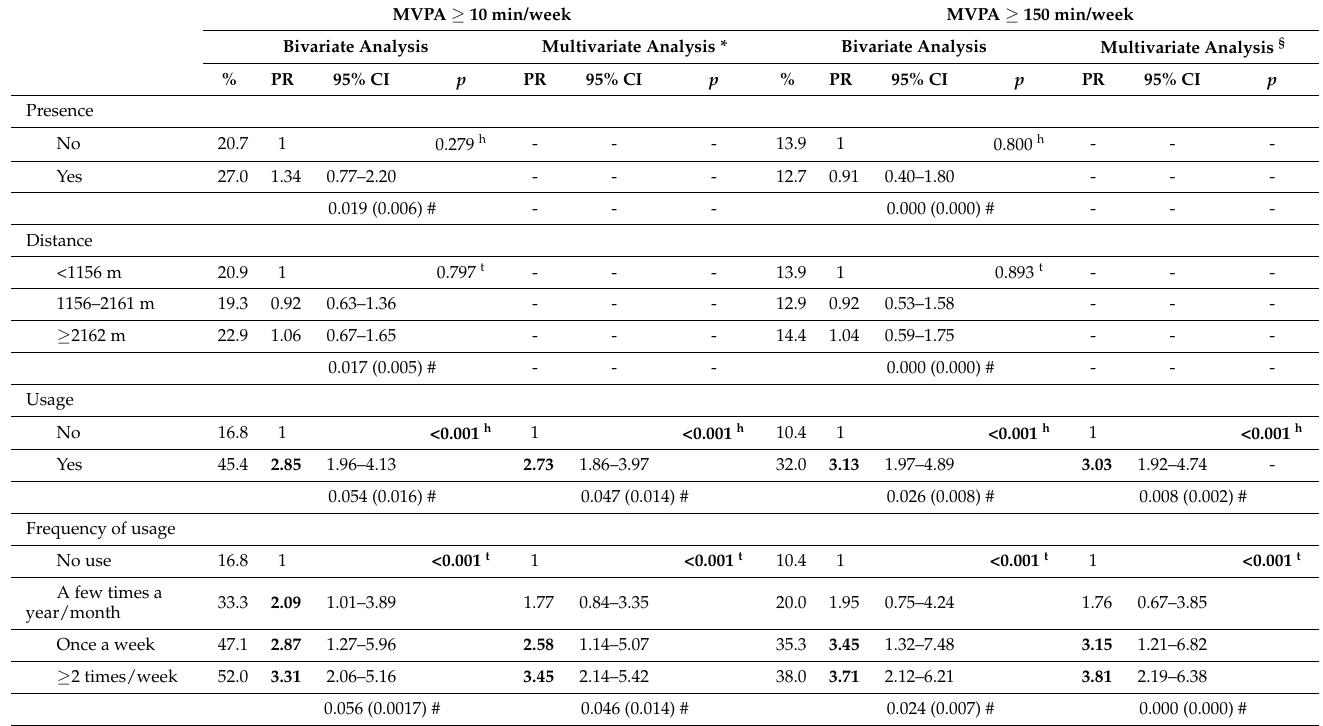
Table 4. The multilevel associations between exposure to public open space and the MVPA in the leisure time of adults in primary health care. S ã o Jos é dos Pinhais, Southern Brazil, 2019 ( n =